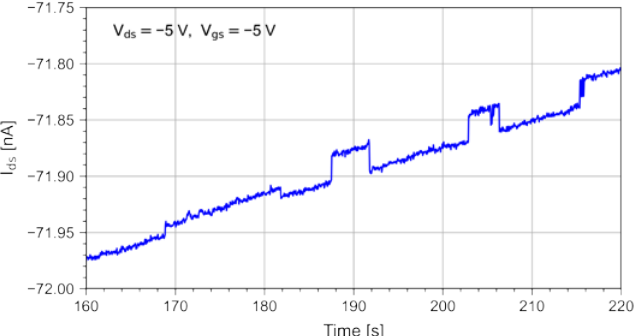
Figure 6. Random telegraph signal behavior in the drain dark current observed for the OPT polarization of V ds = − 5 V, V gs = − 5 V. In order to study possible channel stress effects due to light exposure, we illuminated the DUT with bursts of 20 pulses for different repetition periods: T = 15, 20, 35, 60 s. Figure 7 shows the drain current trend when illuminating the device with bursts of light pulses with different periods. As noted in [29], the exposure to repeated light pulses causes a of the photocurrent [33,39,40].